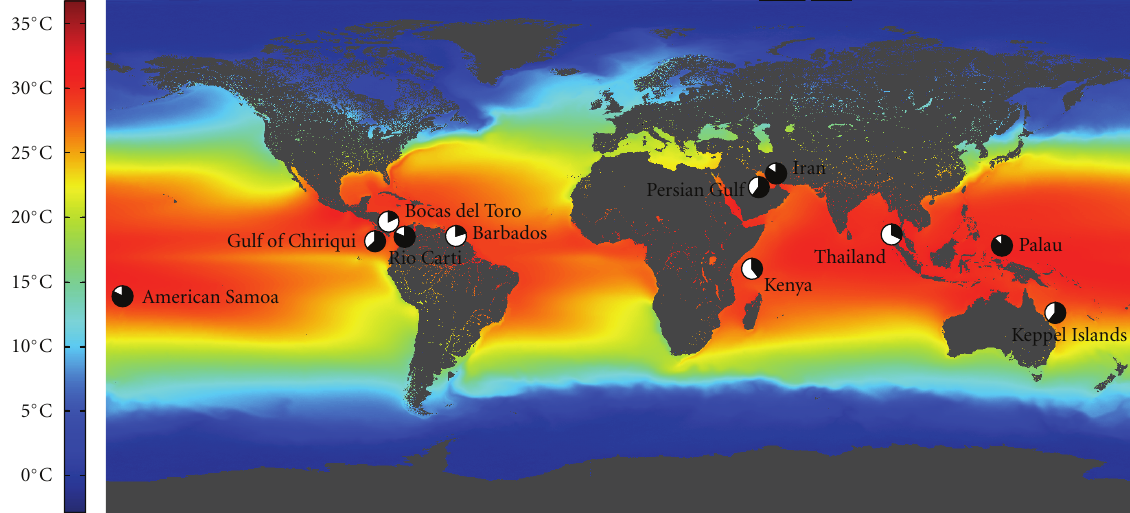
Figure 1: Global map showing mean sea surface temperatures between 1985–2005 from CoRTAD [47]. Black and white sections of pie charts represent the frequency of clade D and C, respectively, from the corresponding studies in Table